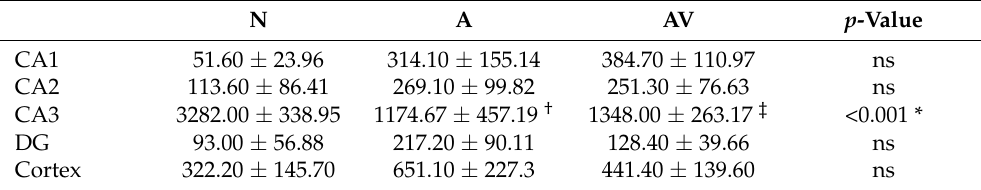
Table 2. Amyloid-beta expression levels in ApoE4-KI mice after auditory and audiovisual